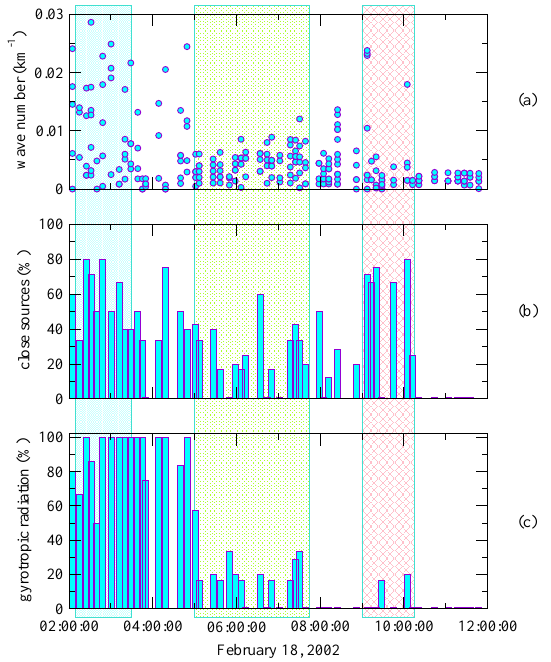
Fig. 7. The wave number (a) , the percent of close sources (b) , and the percent of samples showing gyrotropic wave fields (c) . The statistics are based on a total number of 264 samples distributed over 52 time intervals.